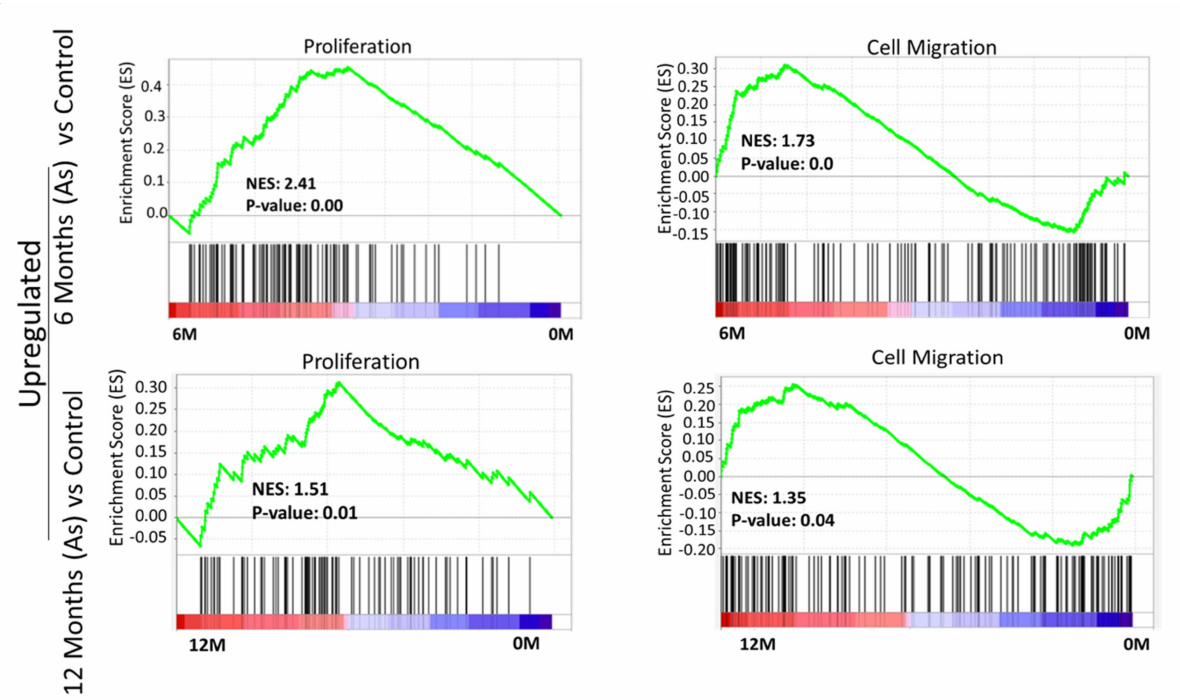
Figure 2. Gene set enrichment analysis (GSEA) of 6-month and 12-month As-exposed cells compared to control with positive enrichment score. GSEA curves of the list of differentially expressed genes in 6-month vs. 0-month and 12-month vs. 0-month. Gene set enrichment at the top of the ranked list is indicated by a positive enrichment score